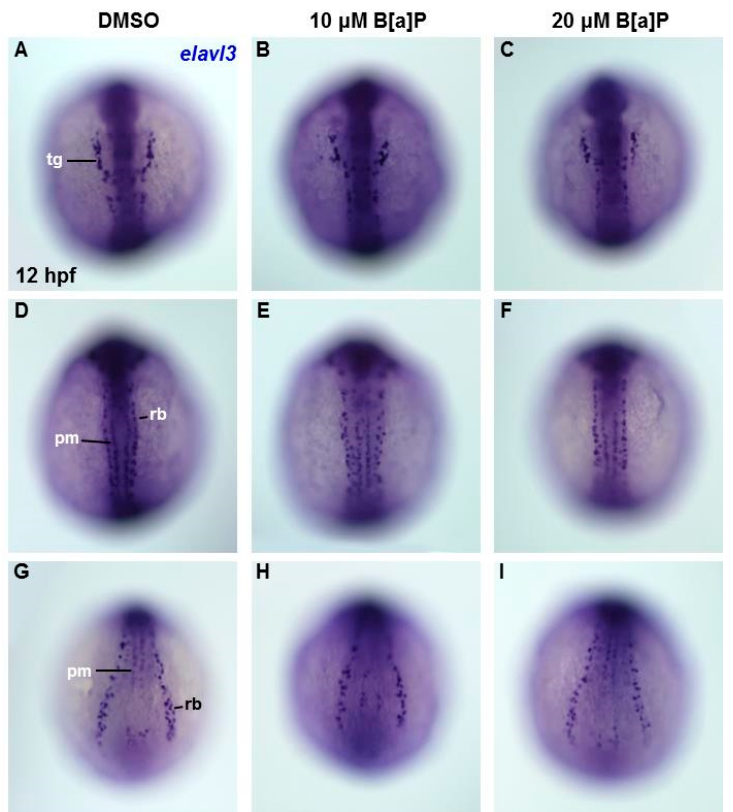
Figure 4. Lack of obvious neural cell defects in B[a] P- treated embryos at 12 hpf. In situ hybridization staining with a probe against elavl3 was performed to analyze the early development of neural cells ( A – I ); all images show the dorsal view. Images in ( A – C ) are focused on the anterior trunk; ( D – F ) are focused on mid-trunk region and ( G – I ) are focused on the tail region. tg, trigeminal ganglion; pm, primary motor neurons; rb, Rohon–Beard cells.